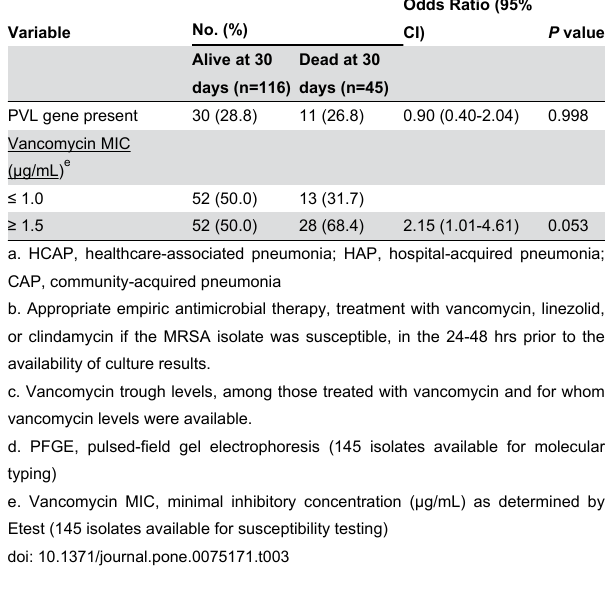
Table 3. Variables associated with 30-day all-cause mortality in univariate analysis in patients with methicillin- resistant Staphylococcus aureus (MRSA) pneumonia.